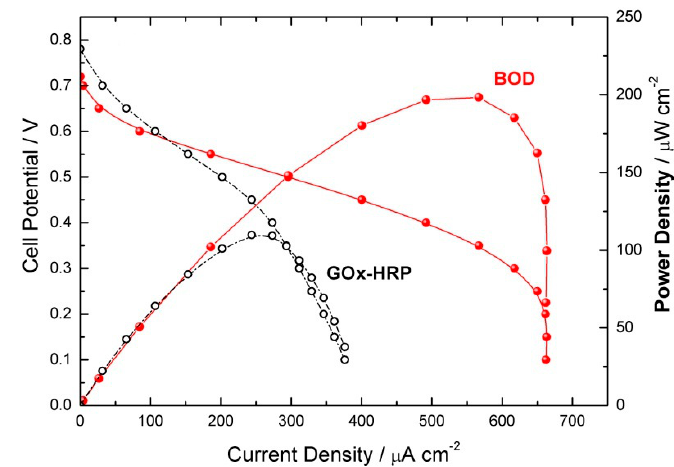
Figure 7. Polarization and power curves of electroenzymatic reactors based on two different cathodes, flow rate 5 mL min − 1 , 20 mM glucose in 0.1 M phosphate buffer, O 2 supply from the gas phase, condition for GOx||GOx-HRP: pH 6.00, 22 °C; GOx||BOD system: pH 7.00, 37 °C.